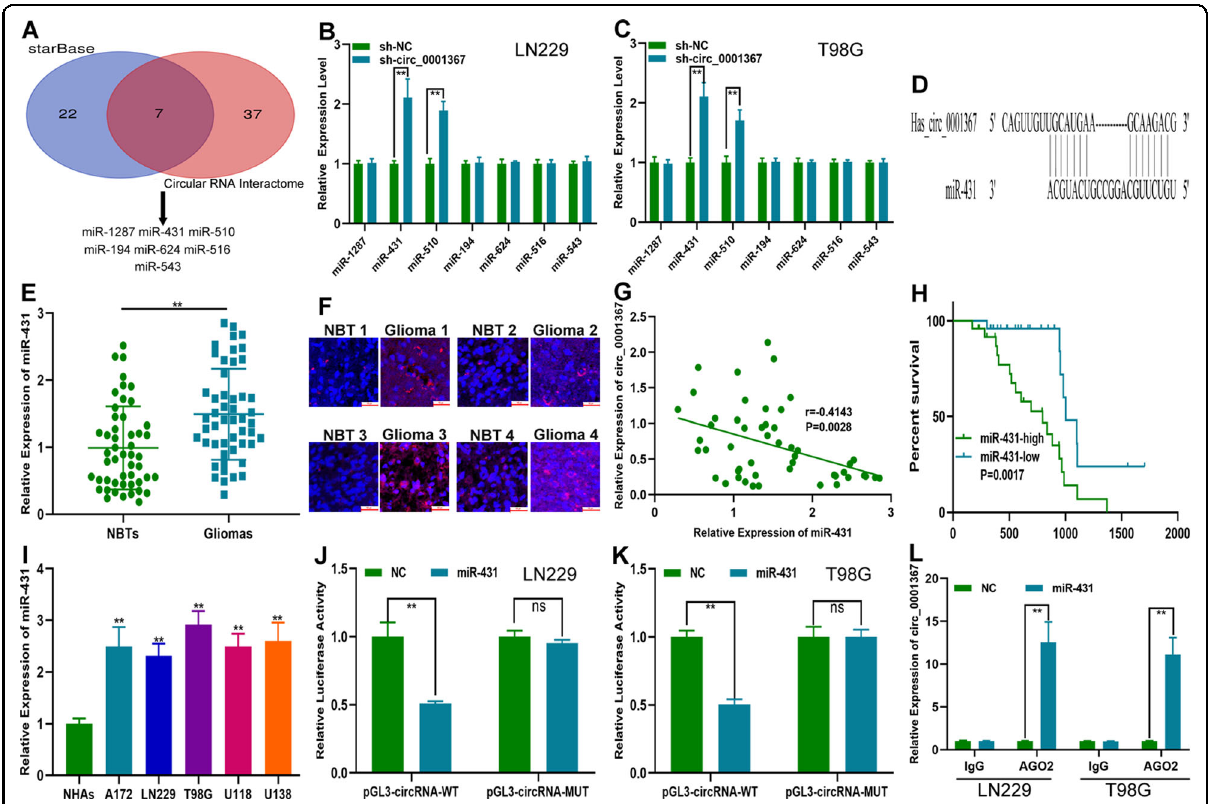
Fig. 4 Circ_0001367 acted as a sponge for miR-431 in glioma cells. A A Venn diagram indicated that seven miRNAs might be biological targets of circ_0001367. B , C Relative expression of candidate miRNAs in LN229 and T98G cells transfected with sh-circ_0001367 or shNC. D Putative binding sites of miR-431 on circ_0001367. E , F The expression of miR-431 in glioma surgical specimens and matching adjacent NBTs was examined with qRT- PCR and FISH (Red: circ_0001367, Blue: DAPI). G Pearson correlation analysis was performed to determine the relationship between circ_0001367 and miR-431. H Kaplan – Meier survival analysis showed that the overall survival of glioma patients differed with high or low miR-431 expression. I MiR-431 expression in glioma cell lines examined using qRT-PCR. J , K Dual-luciferase reporter assays were performed to validate the association between circ_0001367 and miR-431. L RIP assay validated the association between circ_0001367 and miR-431. Each experiment was performed in triplicate. Data are expressed as mean ± SD, ** P <